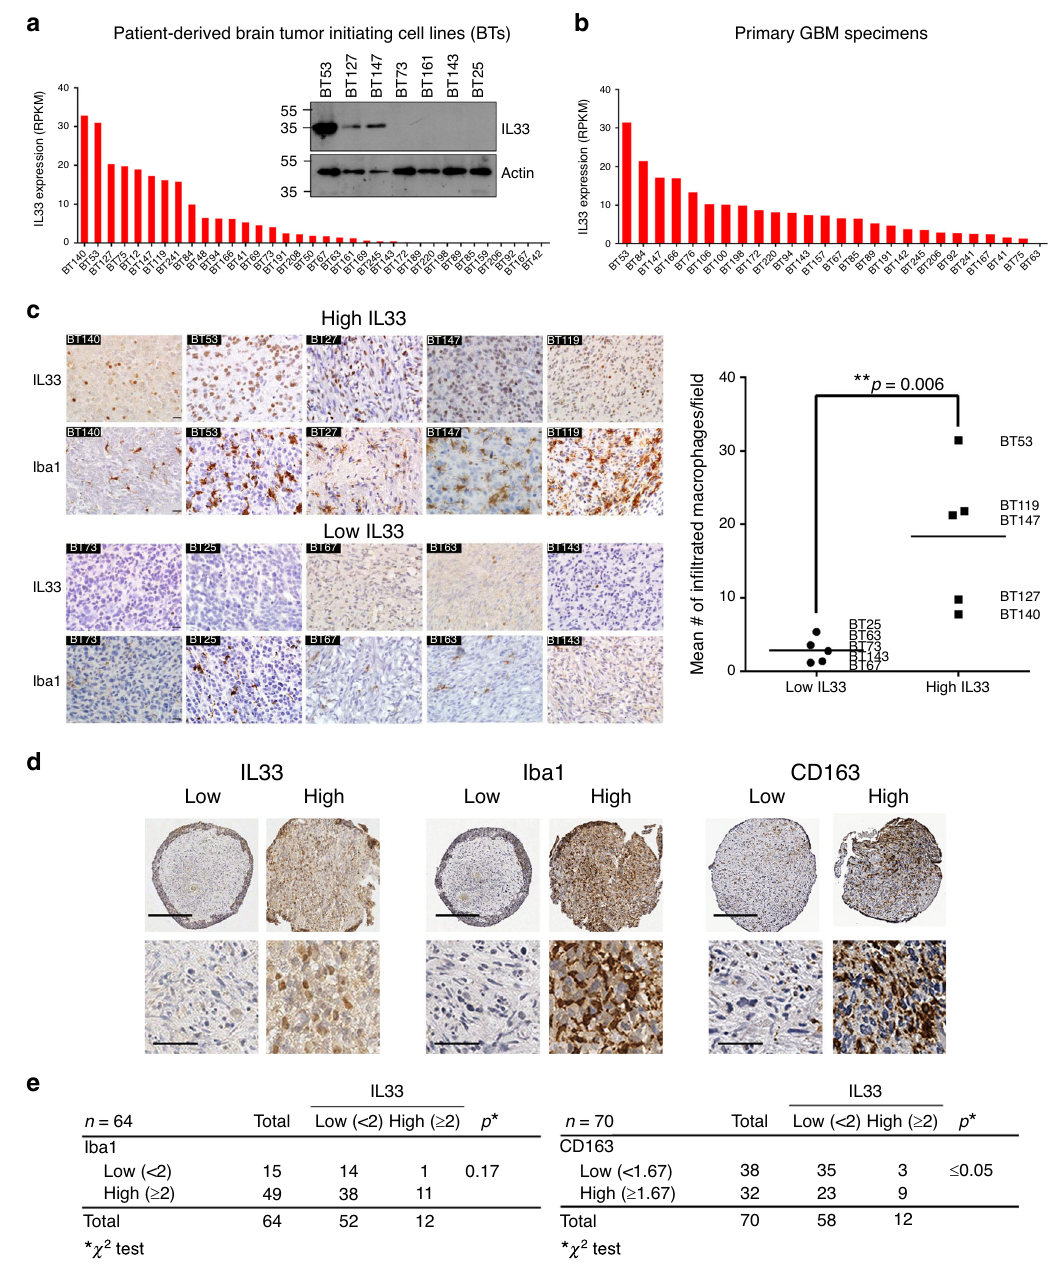
Fig. 2 Human glioblastoma expressing IL-33 correlate with TAM density. a RNA-seq was performed on 35 patient-derived BTICs and 26 primary GBM specimens. Graph shows RNA expression (per million mapped reads; RPKM) of IL-33 in the panel of patient-derived BTIC lines. Insert shows a western blot for IL-33 (upper panel) in a subset of the patient-derived BTICs. Actin was used as a loading control (lower panel). b Graph shows RNA expression (RPKM) of IL-33 in the corresponding primary GBM specimens from which the BTICs were isolated. c IHC of IL-33 (rows 1 and 3; brown) and Iba1 (rows 2 and 4; brown) expression in intracranial xenografts derived from fi ve BTIC lines with high IL-33 expression (BT140, BT53, BT127, BT147, and BT119; upper 2 rows) and fi ve BTIC lines with low/absent IL-33 expression (BT73, BT25 BT67, BT63, and BT143; lower two rows; N = 3). Graph shows quantitation of the number of Iba1 + macrophage per fi eld of view (right panel). Results are expressed as the mean of Iba1 + macrophage in fi ve independent fi elds of view (3 mice/group) per BTIC; ** p = 0.006 by two-sided unpaired Student ’ s t -test. Scale bar, 20 µ m. d IHC of a tissue microarray (TMA) containing 70 glioblastoma patient specimens was assessed for IL-33 (left panel; brown), Iba1 (middle panel; brown), and CD163 (right panel; brown). TMA was counterstained using hematoxylin (blue). Shown are representative images of high and low expression of IL-33, Iba1, and CD163. Scale bar, 200 µ m (upper panels) and 50 µ m (lower panels). e TMA was scored and assessed for an association between IL-33 expression and Iba1 or CD163 expression. The p -value was based on the chi-squared ( χ 2 ) test. See also Supplementary Fig. 2. Source data are available as a Source data fi